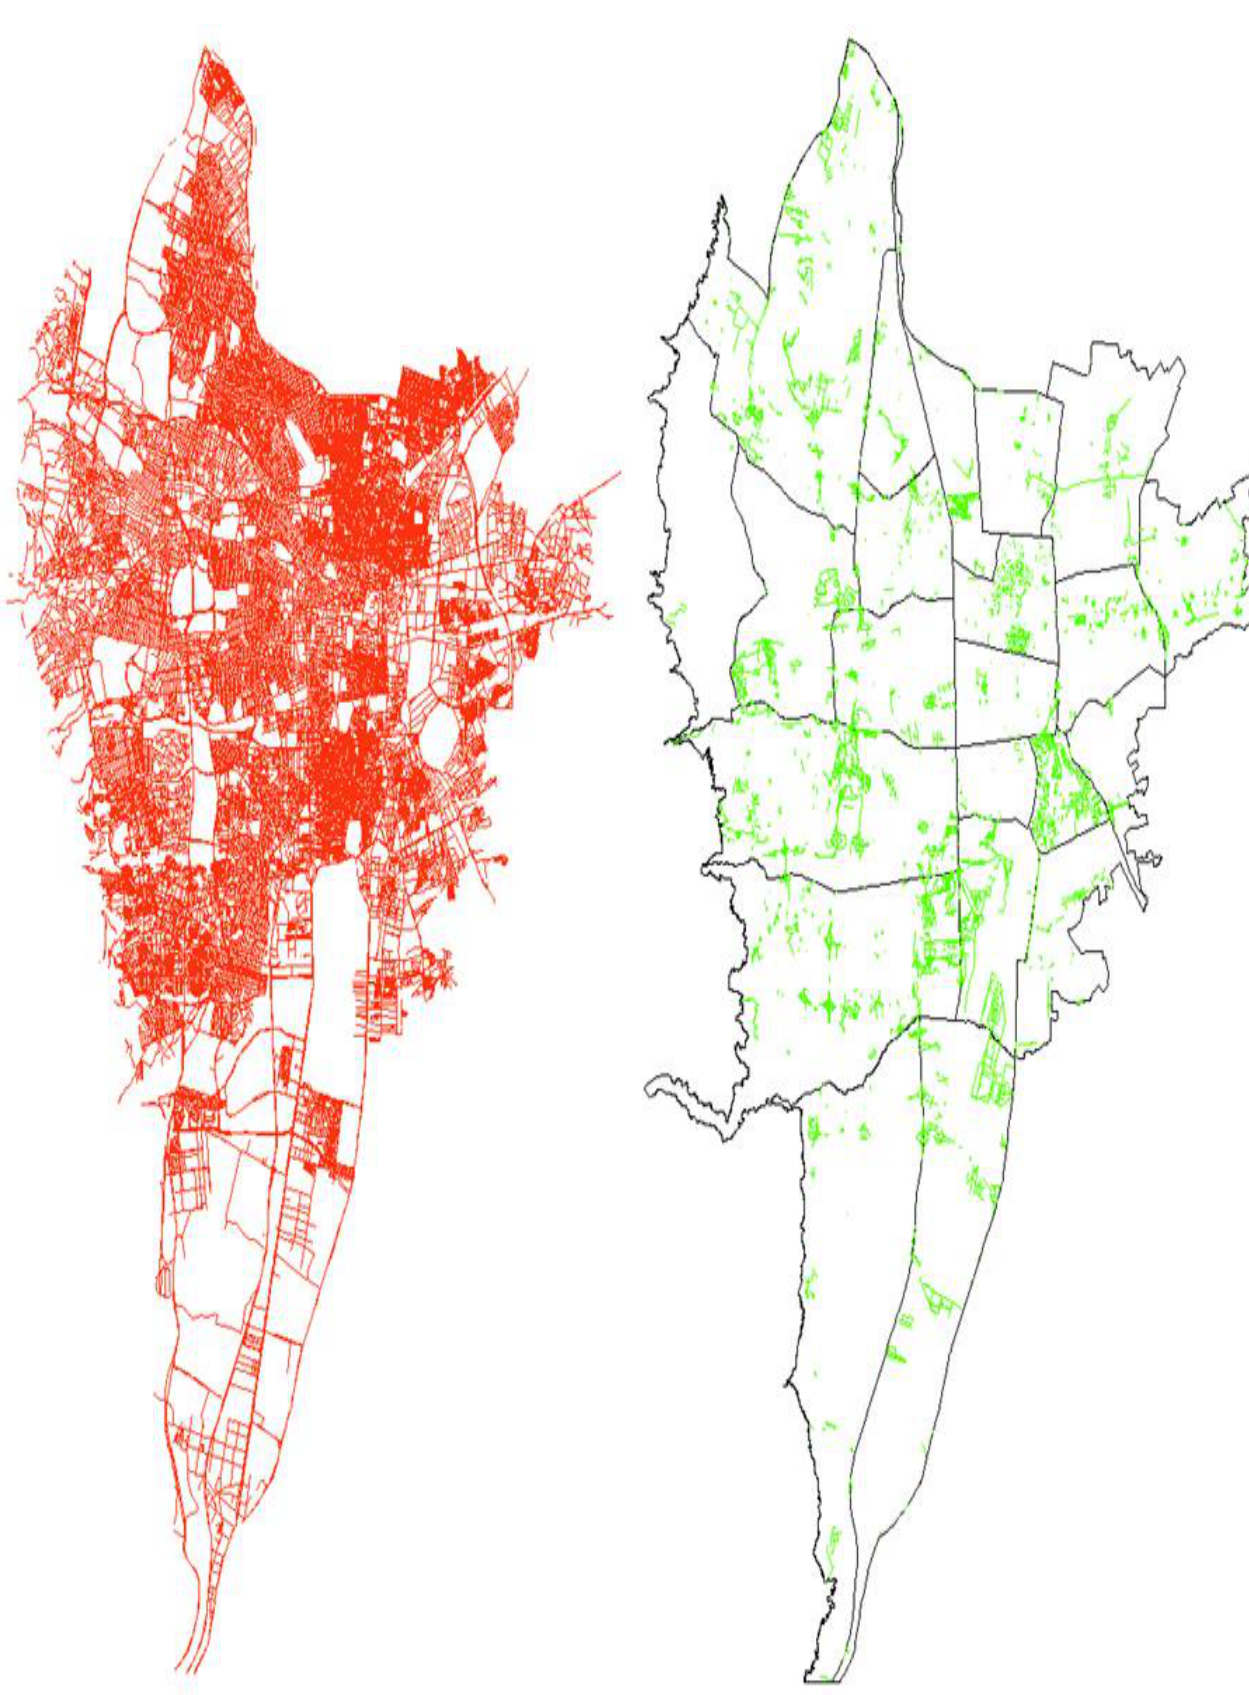
Figure 5: VGI Matched Data of Tehran, Iran Figure 6: VGI Not Matched Data of Tehran,